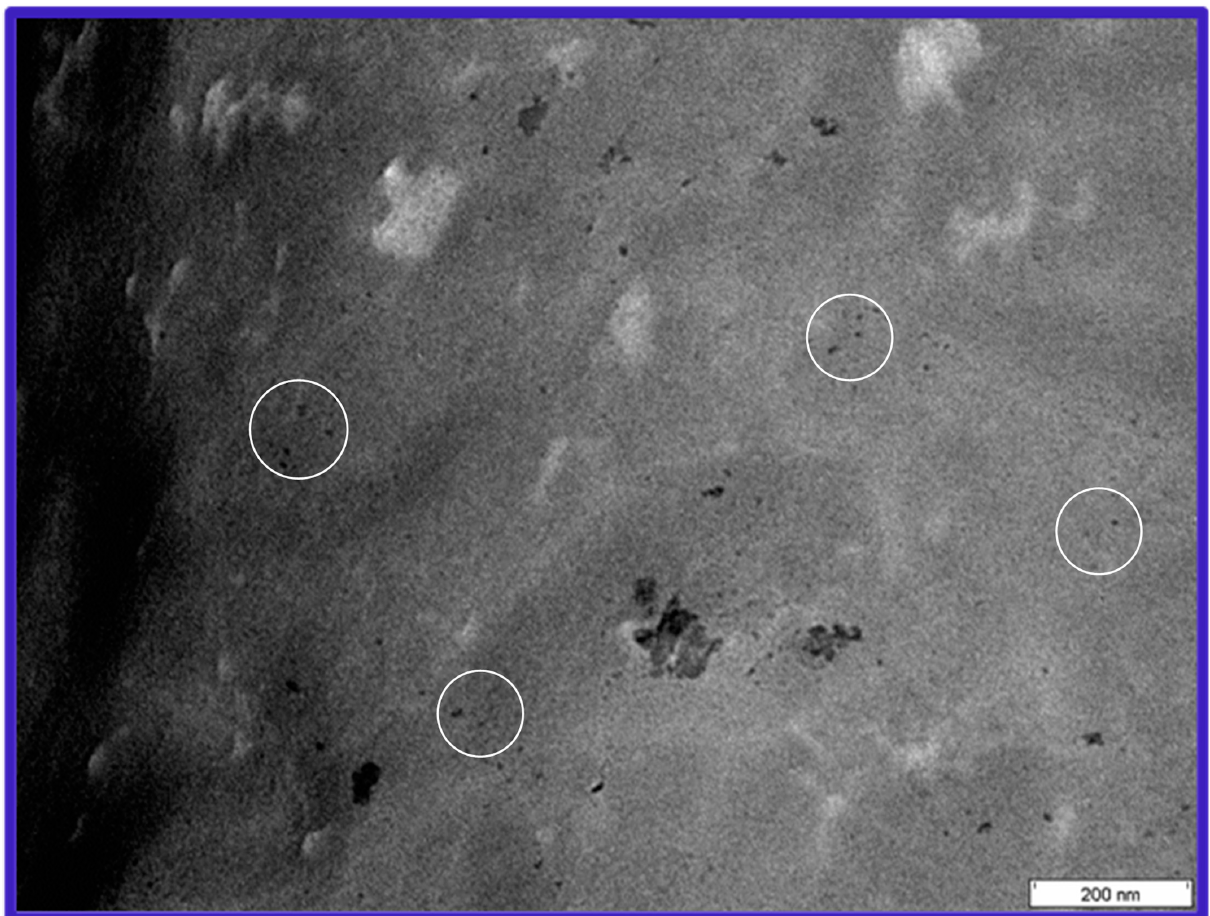
Figure 2. TEM image of the composite DGEBA ( n = 0)/mXDA/AuNP (8.5%). White circles: Examples of isolated AuNPs.